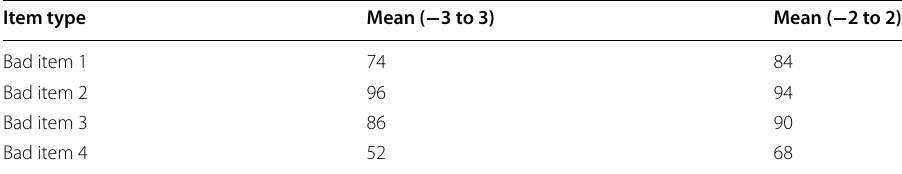
Table 2 Power of the item-fit residuals for LTT math age 9 simulations Item type